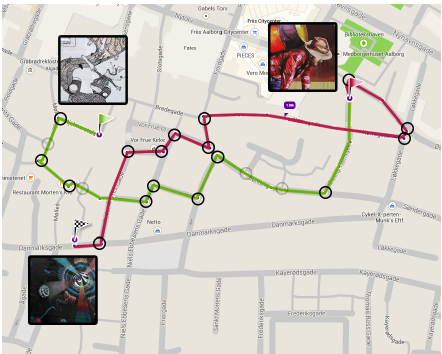
Figure 1. The routebetweenthe three street art